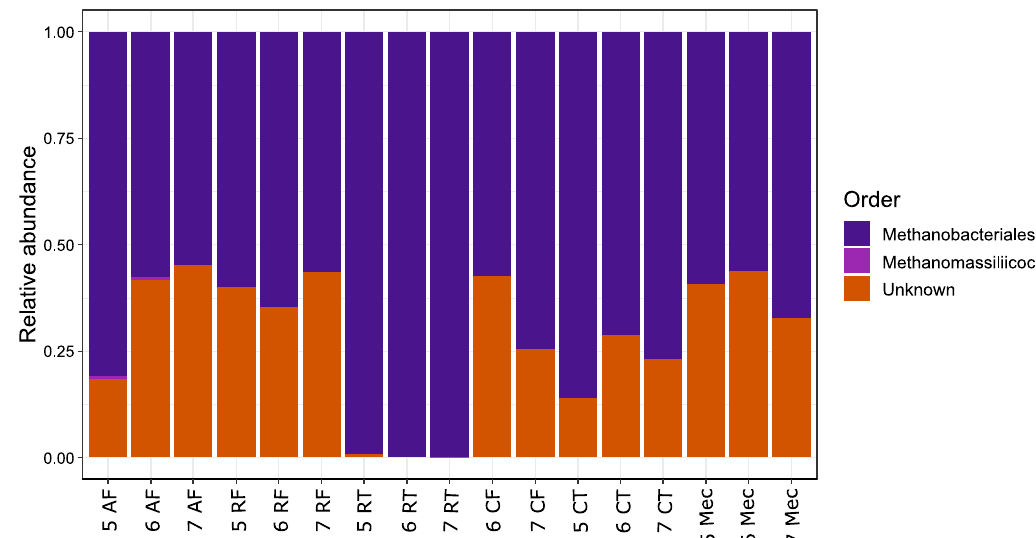
Figure 5. Mean relative abundance of archaeal ESVs in each sample type (GIT component and amniotic fluid) at each gestational age (5, 6 and 7 months). ESVs are clustered by colour to the level of order. ESVs with taxonomic assignments at the order level with confidence values lower than 90% are denoted as ‘Unknown’. The gDNA from caecal tissues at 5 months gestation was below the concentration threshold (0.5 ng/µL) for samples to be included in the sequencing run. Amniotic fluid (AF), ruminal fluid (RF), ruminal tissue (RT), caecal fluid (CF), caecal tissue (CT), meconium